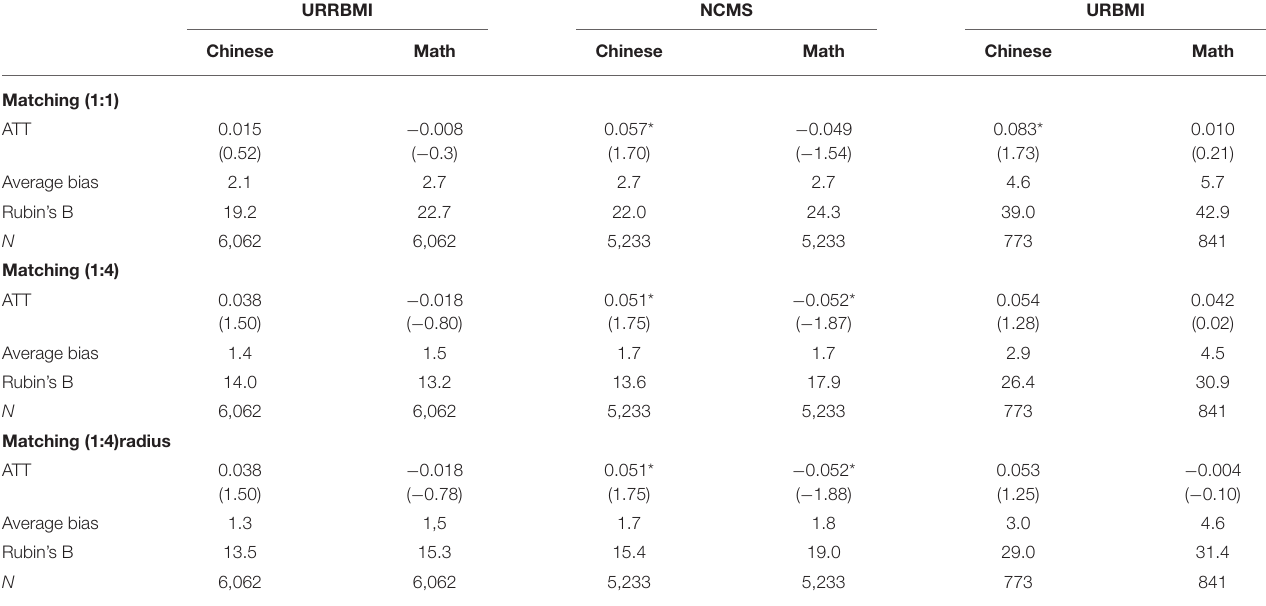
TABLE 6 | Robustness test of PSM matching methods. URRBMI NCMS URBMI Math